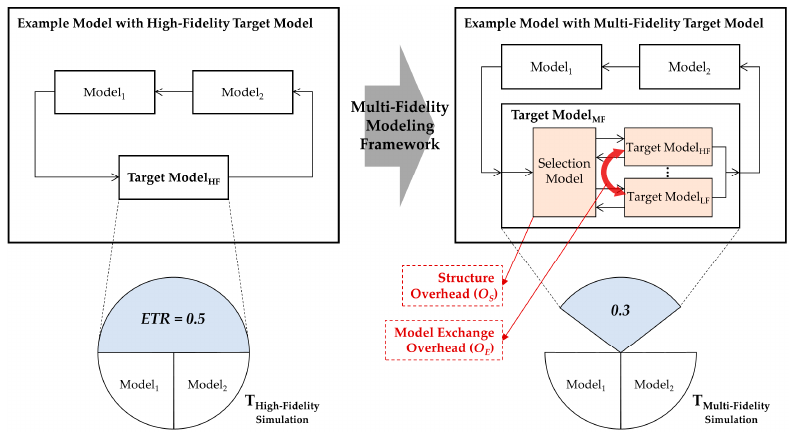
Figure 12. Simulation speedup using the proposed multi-fidelity modeling framework.